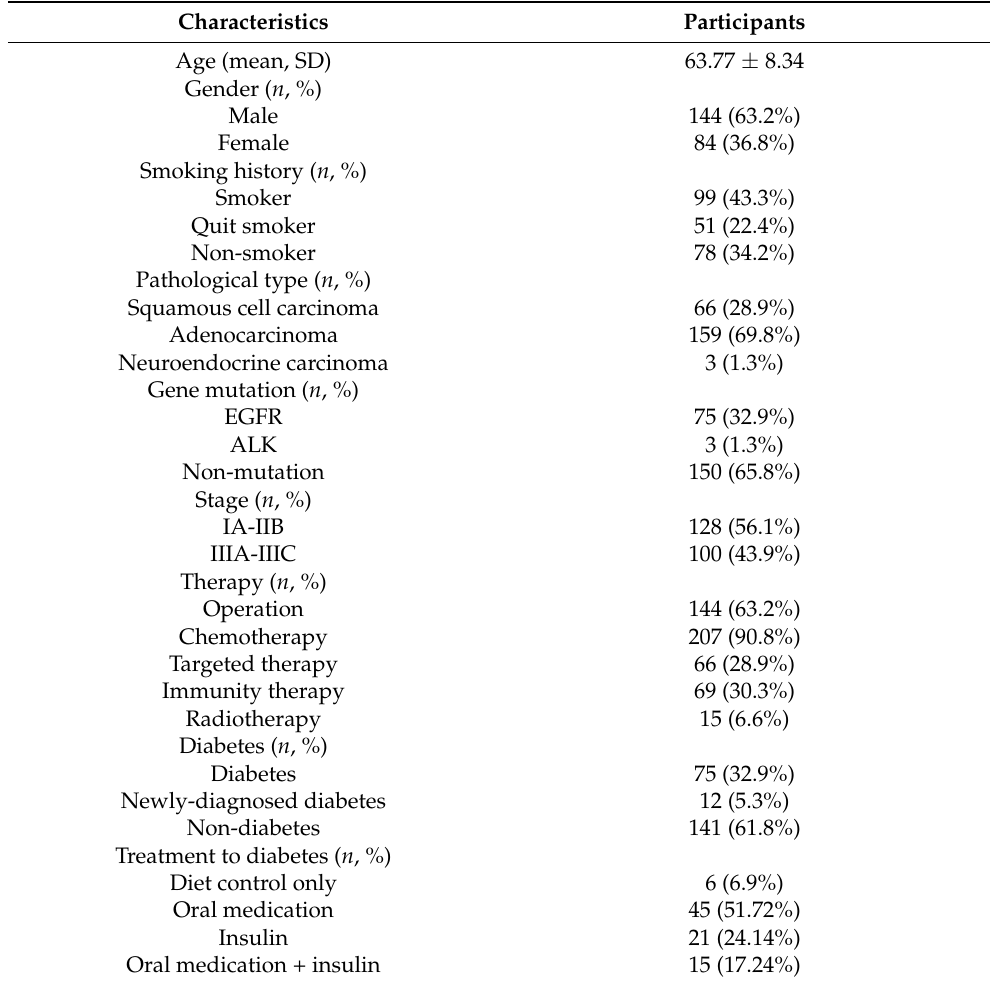
Table 1. Characteristics of